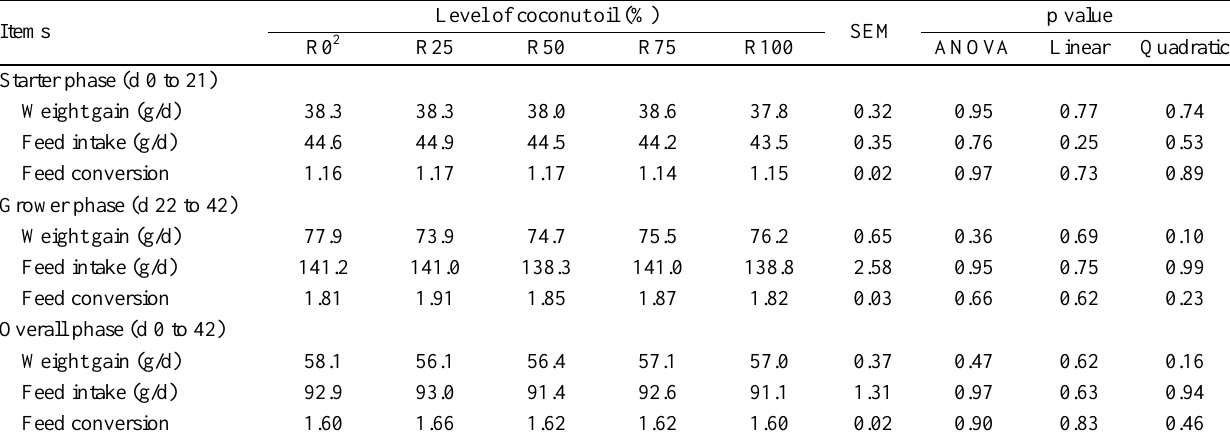
Table 3. Effect of dietary coconut oil as a medium-chain fatty acid (MCFA) source on performance of broilers 1